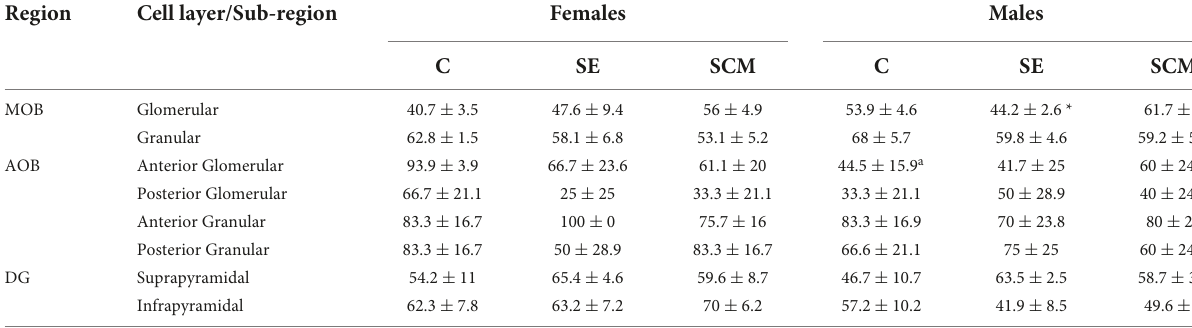
TABLE 1 Percentage of new mature neurons that survive in the olfactory bulbs and dentate gyrus of the hippocampus. Cell layer/Sub-region Females